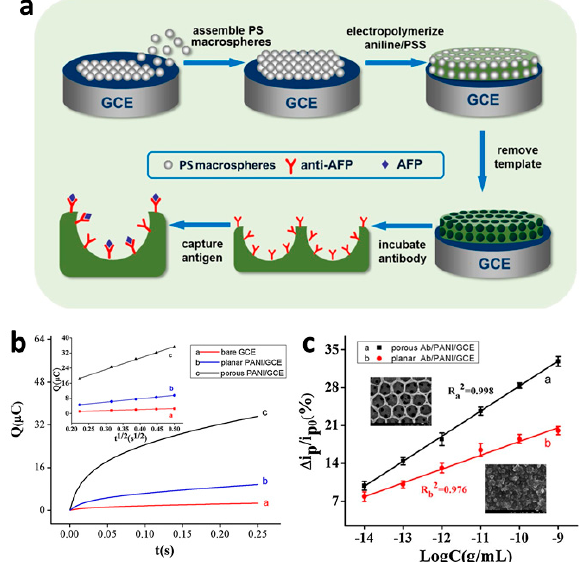
Figure 17. ( a ) Preparation of a microporous PANI:PSS / anti-AFP immunosensor. ( b ) Chronocoulometry of the reduction of 0.2 mM K 3 Fe(CN) 6 with 0.1 M KCl revealed that the macroporous PANI:PSS